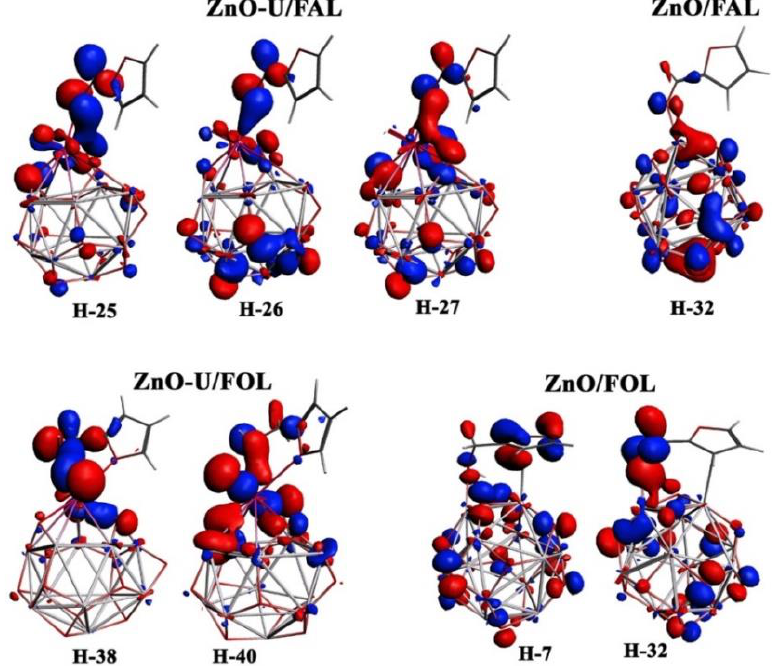
Figure 5. Selected characteristic orbitals of Cat/FAL and Cat/FOL (Cat = ZnO and